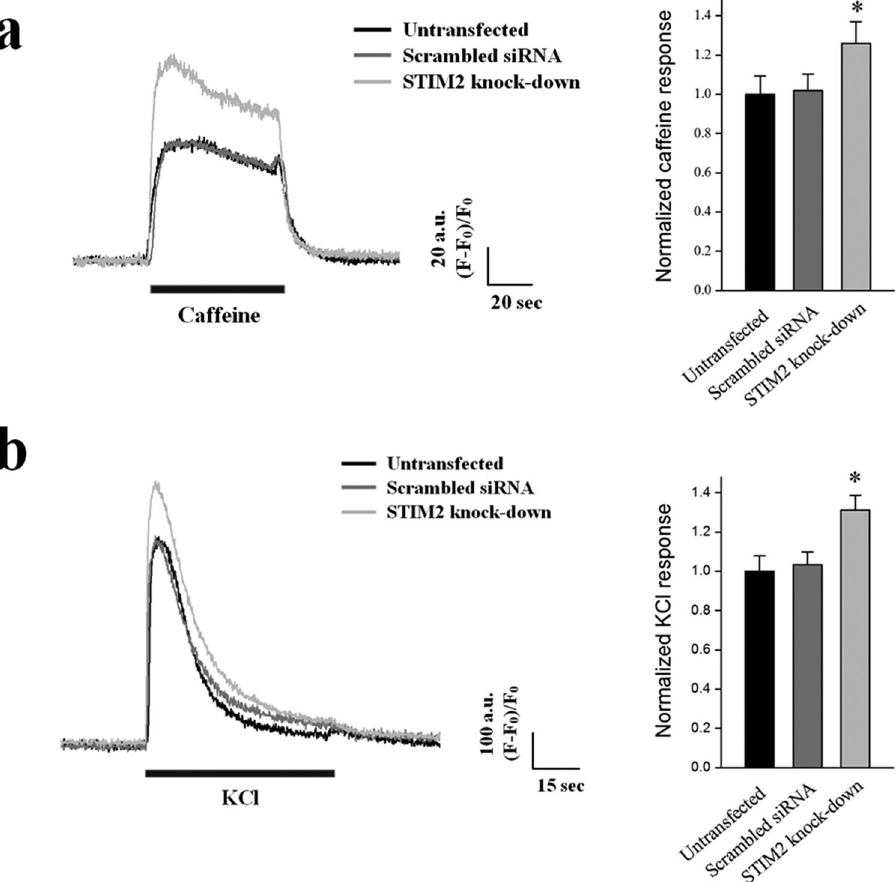
Figure 5. Enhanced intracellular Ca 2 + release through RyR1 in response to caffeine or KCl by STIM2- knockdown. Caffeine (a specific agonist of RyR1) ( a ), or KCl (a membrane depolarizer) ( b ), was applied to the STIM2-knockdown myotubes, and the intracellular Ca 2 + release from the SR to cytosol through RyR1 in the myotubes was measured. Histograms are shown for the normalized peak amplitude to the mean value of those from the untransfected control. The results are presented as the mean ± S.E. for the number of experiments in the parentheses in Table 4. * Significant difference was compared with the untransfected controls ( P < 0.05). Intracellular Ca 2 + releases in response to either caffeine or KCl is significantly increased by